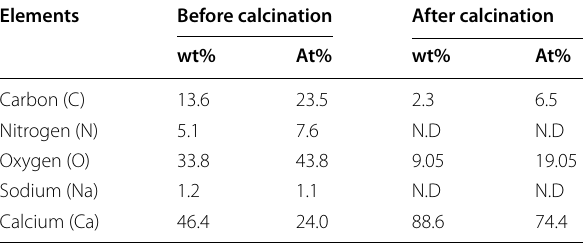
Table 1 EDS analysis results for elemental composition of eggshell